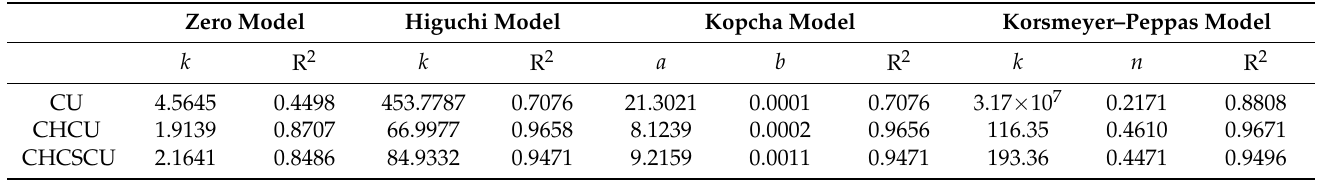
Table 2. Model parameters for curcumin (CU), and CU ‐ loaded nanoparticles with chitooligosaccha ‐ rides (CH), and chondroitin sulfate (CS) after fitting the in vitro drug release data to four different mathematical models.